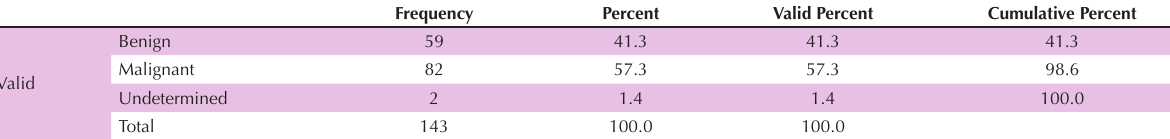
Table 3. Results of surgical examination